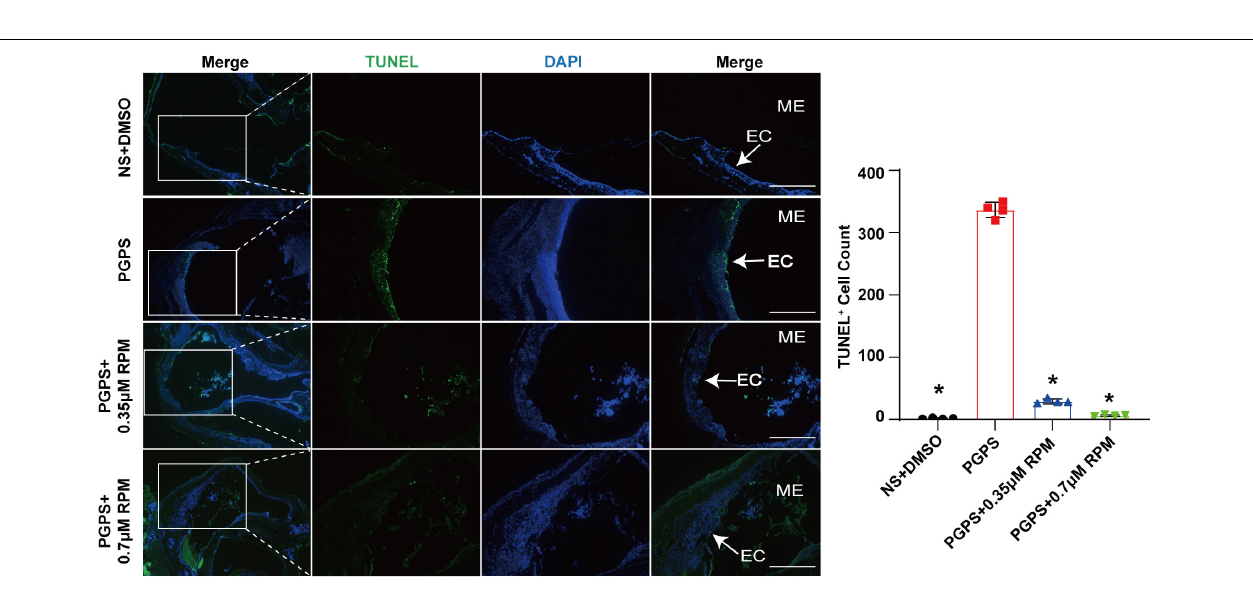
Frontiers in Cellular Neuroscience |